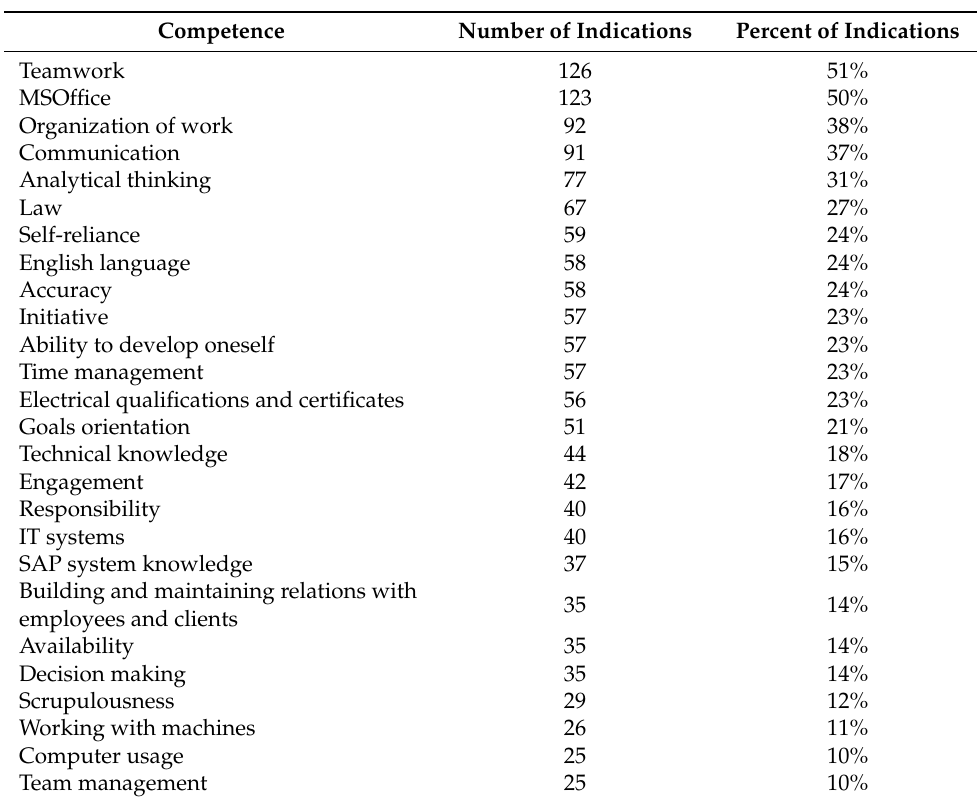
Table 9. Most required competencies.